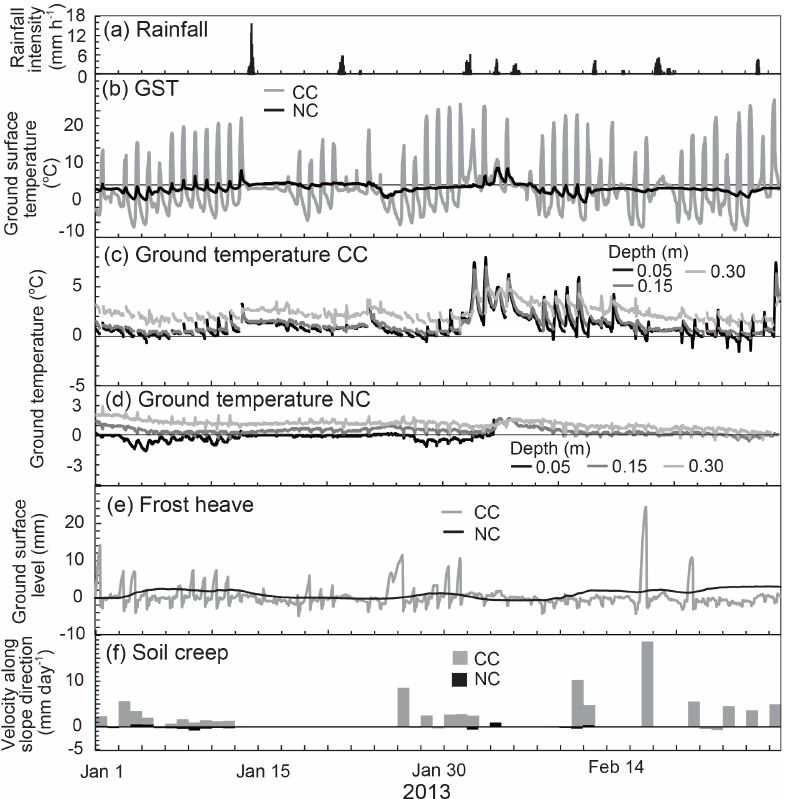
Figure 6. Frost heave and soil creep activities in winter (1 January to 28 February 2013). (a) Rainfall intensity at site MU. (b) Ground surface temperature (GST) in sites CC (CCS) and NC (NCS). (c) Ground temperature in CC (CCR) measured by thermocouples. (d) Ground temperature in NC (NCR) measured by thermocouples. Monitoring of the ground temperature at 5cm depth was interrupted by a defect of the thermocouple from 4 February onwards. (e) Changes in the ground surface level measured by extensometers at CC (CCR) and NC (NCR). (f) Velocity of ground surface sediment along the slope direction obtained from TLC images.